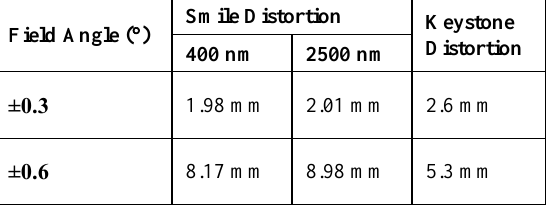
Table 8. Keystone and smile distortion results